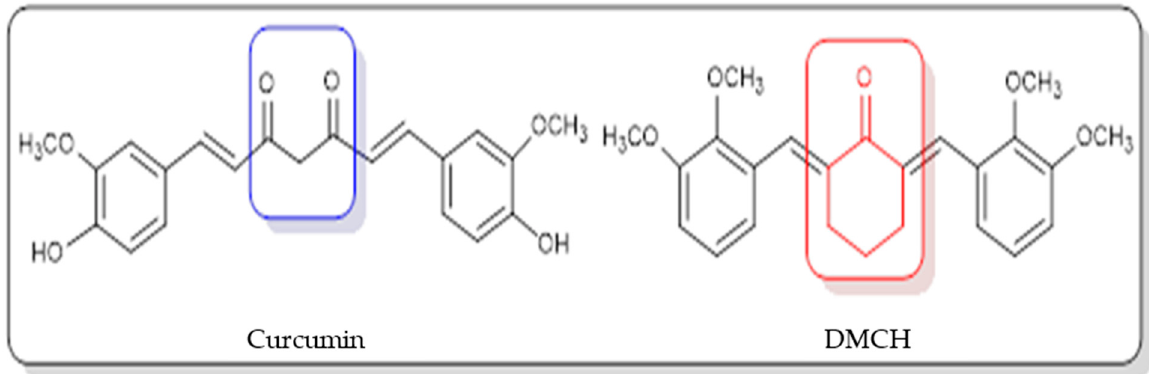
Figure 1. Chemical structures of curcumin and (2E,6E)-2,6-bis(2,3-dimethoxybenzylidene) cyclohexanone (DMCH).